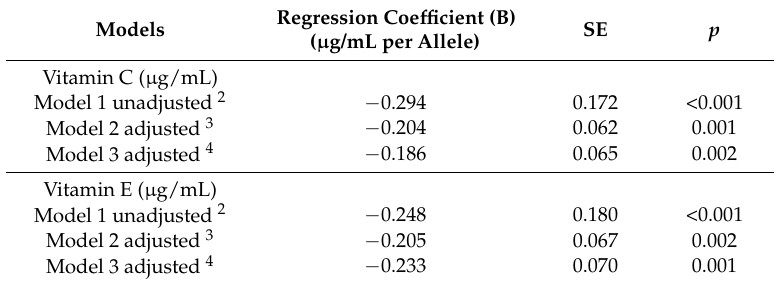
Table 4. Association between the unweighted genetic risk score (uGRS) 1 and plasma concentrations of vitamins C and